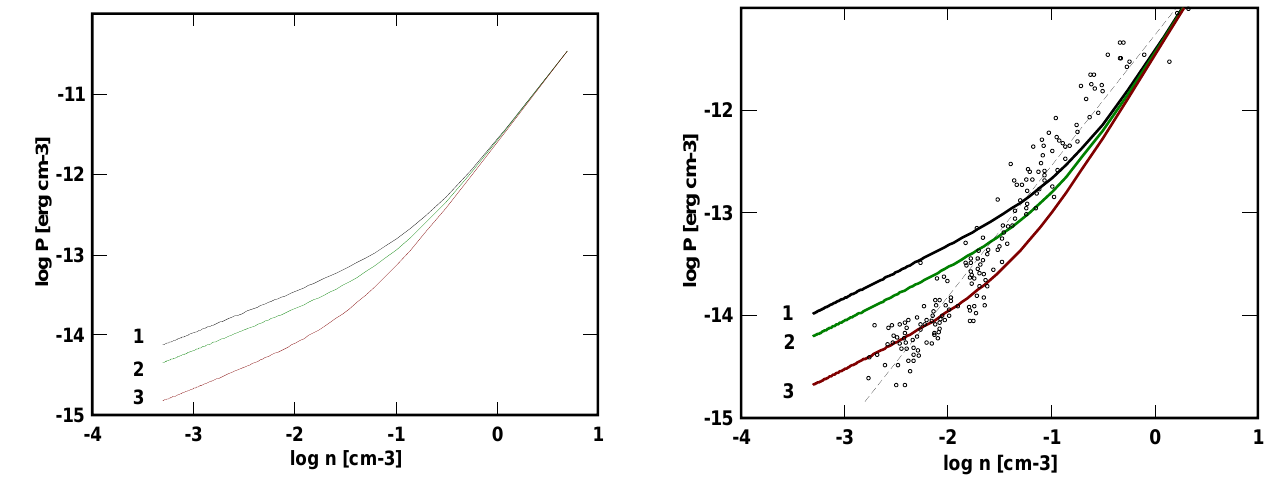
Fig. 3. Plotted is the logarithm of the solar wind pressure P 1 versus the logarithm of the density n 1 at 1α = 50 and T 1 , 0 = 5 · 10 4 K for different values of 3 , i.e. for 1: 3 = 1 · 10 − 3 , 2: 3 = 2 · 10 − 3 , 3: 3 = 3 · 10 − 3 . For comparison purposes data from the VOY- AGER space probes are plotted as dots with a best fitting straight line (dashed curve), according to a polytropic index of γ ∗ (see Whang,